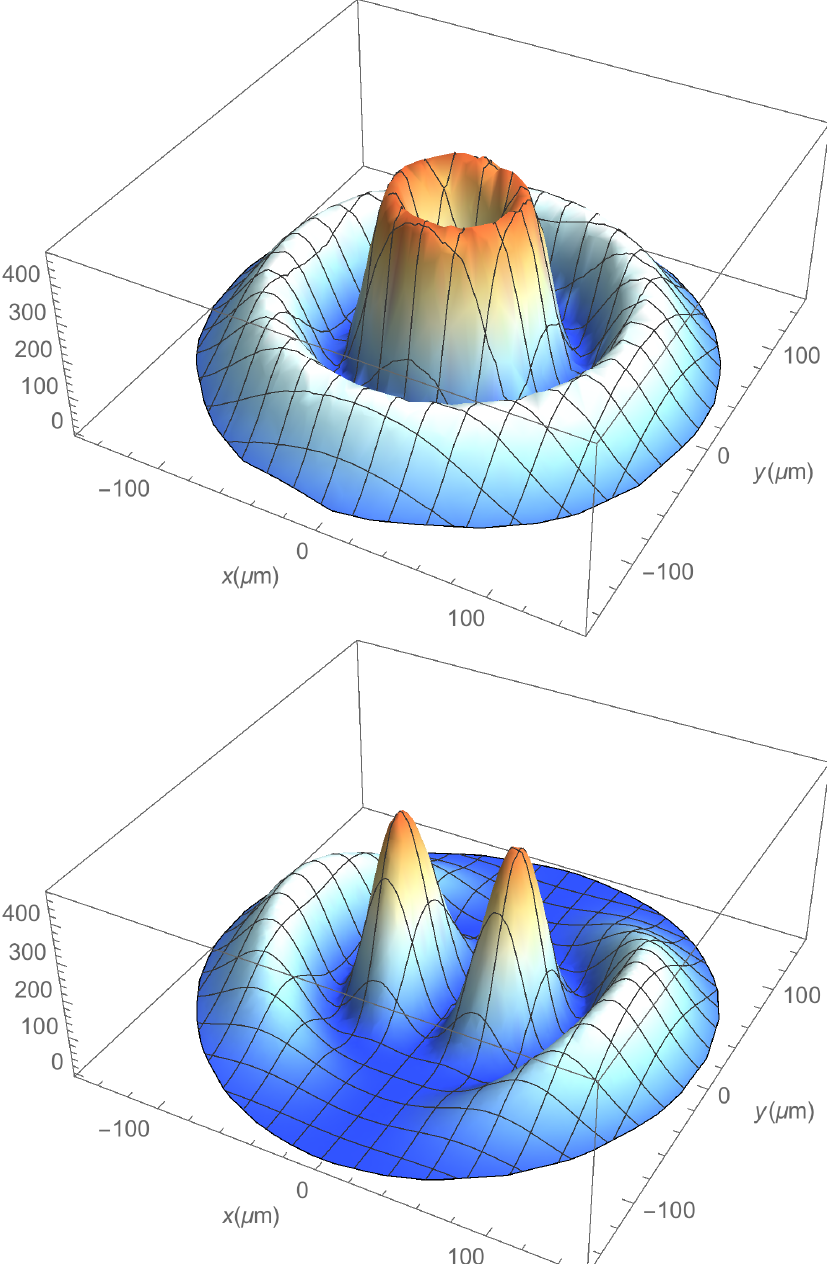
Figure 13. Top panel, 3D asymptotic kinetic energy plot for an uniform random distribution of initial (cid:113) + y 2 ≤ 1.5 × w x 2 conditions fulfilling ρ 0 = 0 and full paraxial fields. Vertical axis units are keV. 0 0 Its rotational symmetry around the propagation axis is apparent. Bottom panel, the same as top one, except for longitudinal fields set to zero. Now the symmetry is lowered, although distributions coincide along the polarization